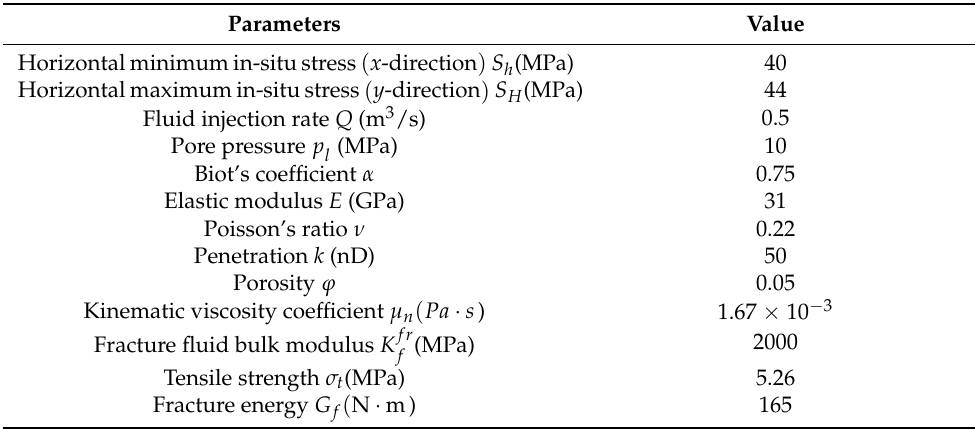
Table 2. Basic physical parameters of the numerical model. Parameters